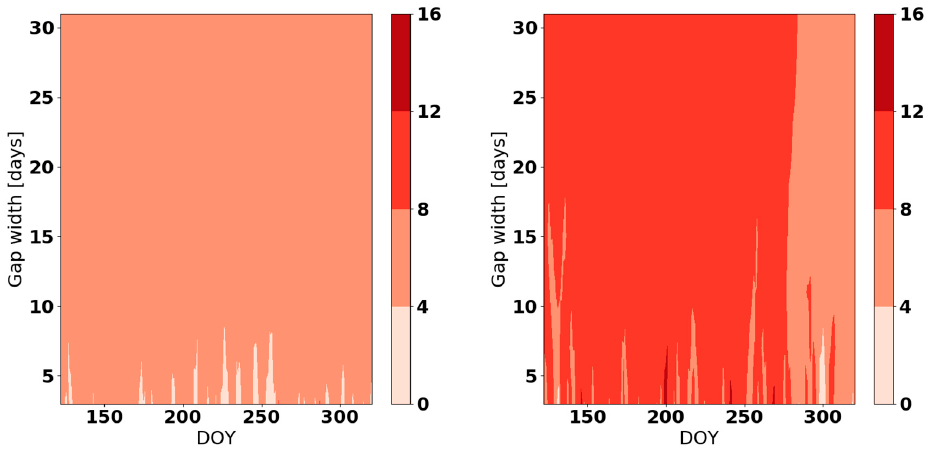
Figure A5. B DEB ( top , left panel ), B ERA5 ( top , right panel ), U(B) DEB ( bottom , left panel ), and U(B) ERA5 ( bottom , right panel ) calculated using data for DOY 122–320 2016 in Pianosa.